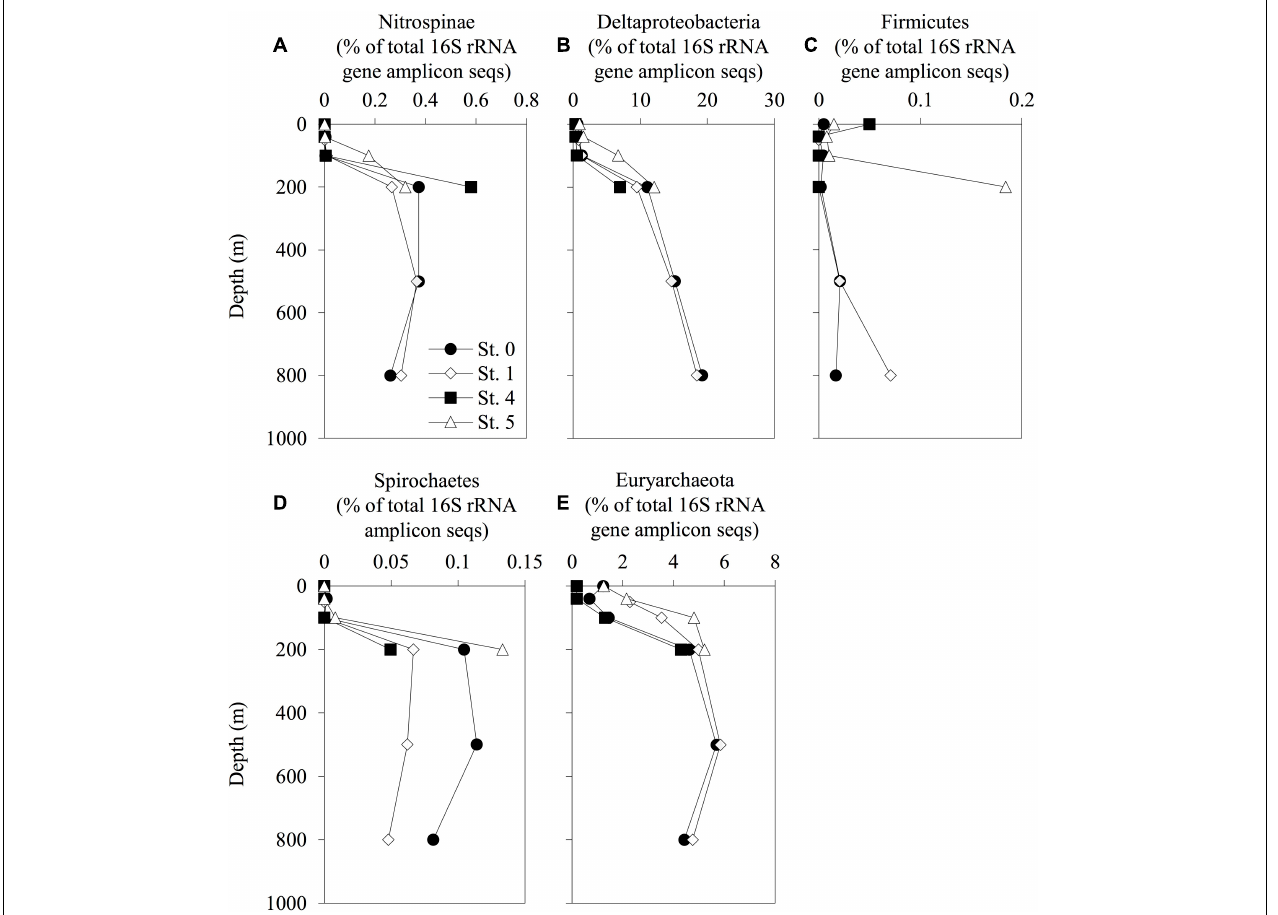
FIGURE 4 | Depth distribution of prokaryotic phylotypes involved in mercury methylation. The relative abundance of Nitrospinae (A) , Deltaproteobacteria (B) , Firmicutes (C) , Spirochaetes (D) , and Euryarchaeota (E) and their total 16S rRNA amplicon sequences are displayed. The profiles do not extend to the bottom